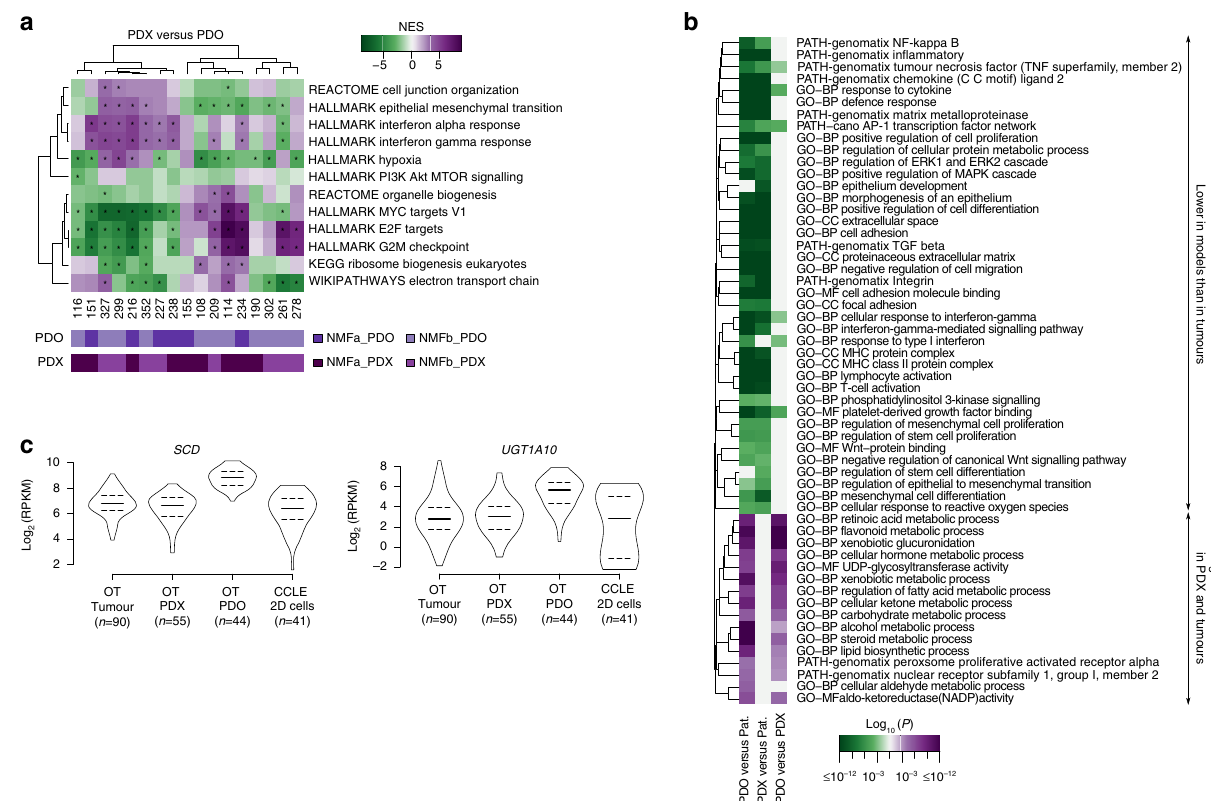
Figure 5 | Comparative gene expression profiling between PDO and PDX models. ( a ) Differentially expressed canonical pathway gene signatures. Positive or negative normalized enrichment scores (NES) calculated for PDX versus PDO for each given pathway are indicated in purple or green shades, respectively. Asterisks indicate significant enrichment with FDR o 0.005. The gene set enrichment was determined using a pre-ranked GSEA. Genes were ranked according to their expression fold change and expression difference between the corresponding model pairs. ( b ) Differential expression of gene signatures for canonical pathways and GO terms in PDO versus tumour, PDX versus tumour and PDO versus PDX. Green and purple boxes indicate log 10 ( P -values) for down- or up-regulated gene sets, respectively. Tumour samples with a tumour purity Z 40% are shown. ( c ) Violin plots showing the expression of SCD and UGT1A10 in the OTcohorts (patient tumour purity Z 40%, PDX and PDO) and CCLE 2D colorectal cancer cell lines (see methods). Lines mark the 25%, 50% and 75%